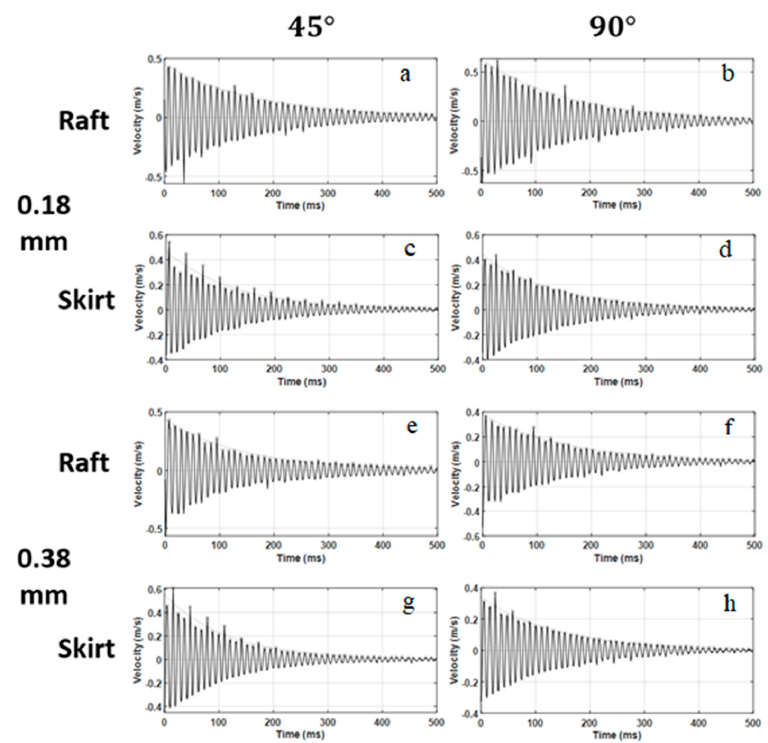
Figure 6. Time-series ring-down free-vibration response obtained from the tested 3D printed cantilevers: ( a ) R-45-0.18 mm, ( b ) R-90-0.18 mm, ( c ) S-45-0.18 mm, ( d ) S-90-0.18 mm, ( e ) R-45-0.38 mm,